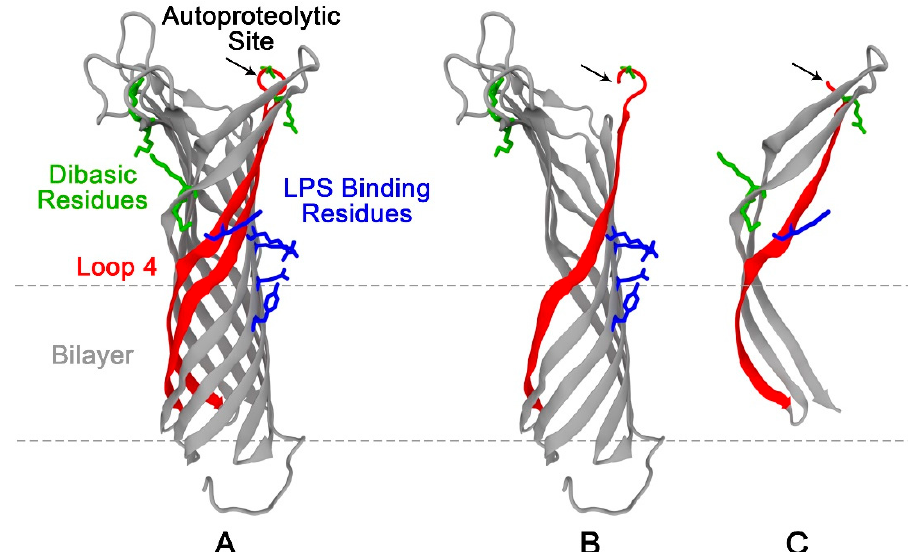
Scheme 1. Structure of outer membrane protease (OmpT) and its autoproteolyzed fragments. ( A ) Ribbon representation of OmpT with the five predicted lipopolysaccharide (LPS) binding residues (blue) and the three dibasic sites represented in licorice (green). Black arrow points at the location of the dibasic site on loop 4 (red) that is prone to autoproteolysis yielding the two autoproteolytic fragments ( B , C ). Note: Crystal structure of wild type OmpT is not available. The Protein Data Bank (PDB) structure (1I78) of mt OmpT DB , an OmpT mutant (mt) that has one of its dibasic (DB) sites